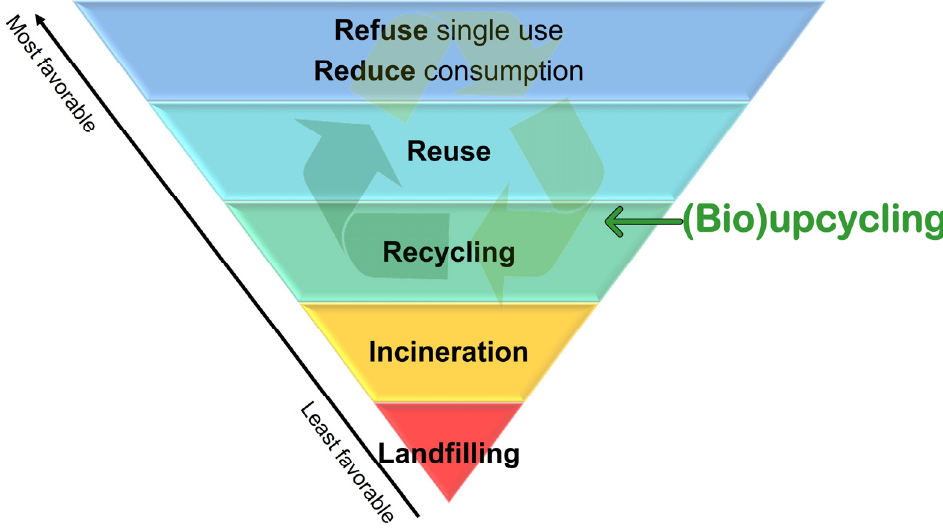
Figure 5. The hierarchy of plastic waste management according to EU Waste Framework